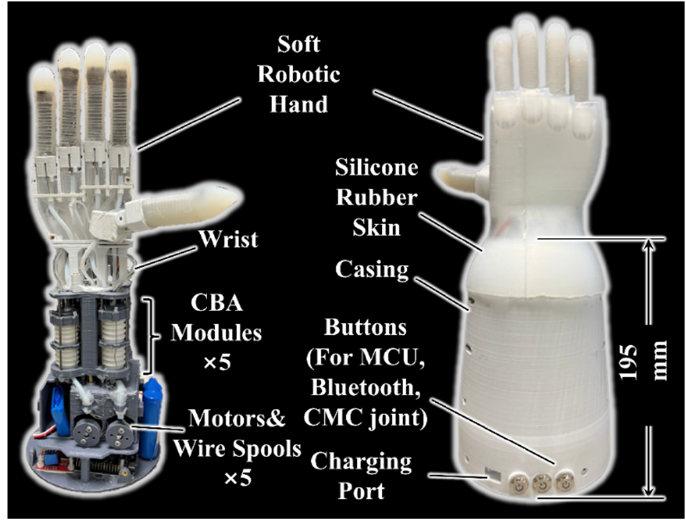
Figure 5. Robotic hand with a forearm prototype.